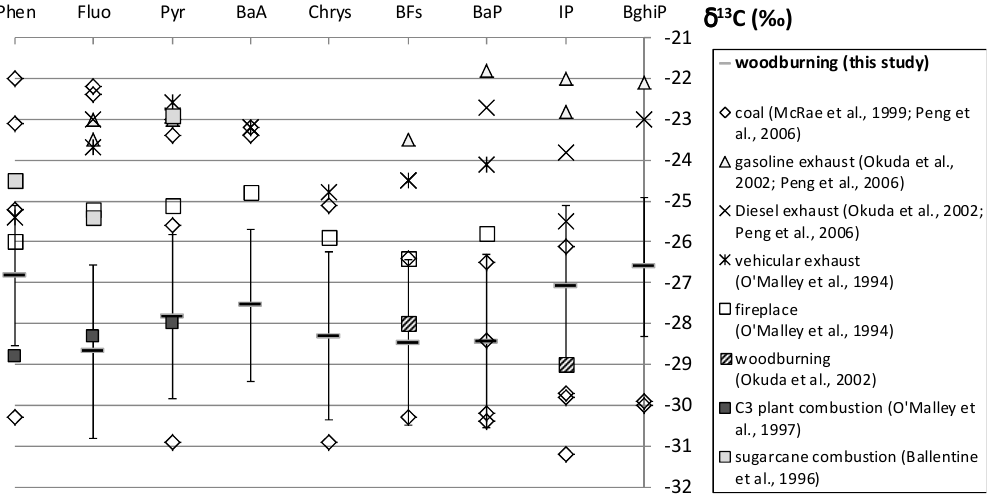
and benzo(e)pyrene data, isotopic compositions do not al- low separation of hardwoods from softwoods and the vari- ations of δ 13 C are probably not induced by this repartition of species (Fig. 3). Nevertheless, the uncertainties on these measurements of isotopic compositions allow differentiation of the origin of particulate-PAHs between the different wood species, by combining the results of several PAH isotopic